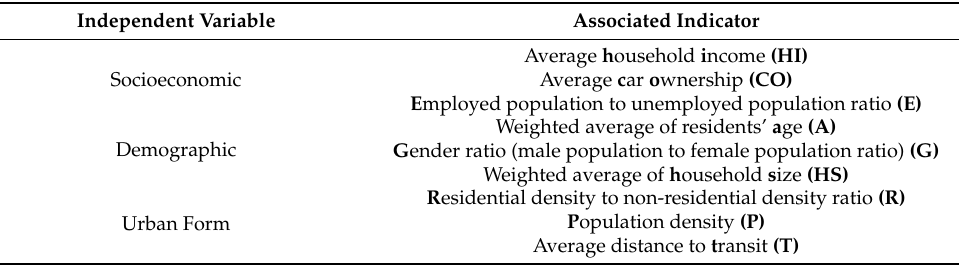
Table 1. Indicators used to develop independent